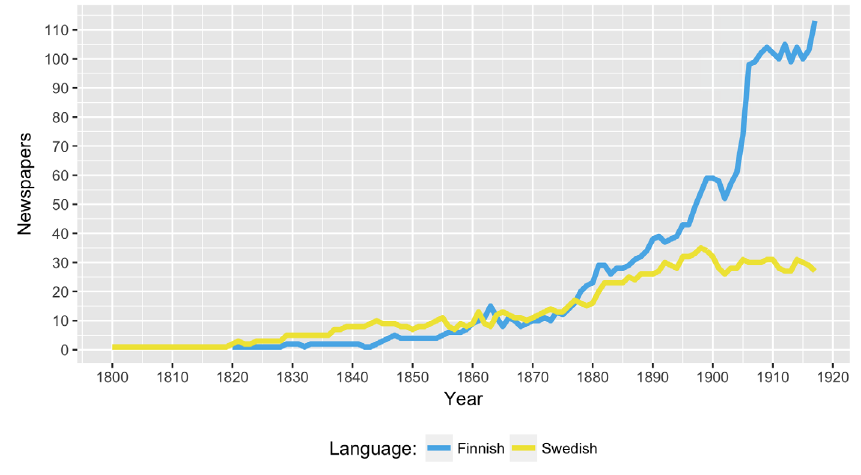
Distinct newspapers published per year in Swedish and in Finnish,